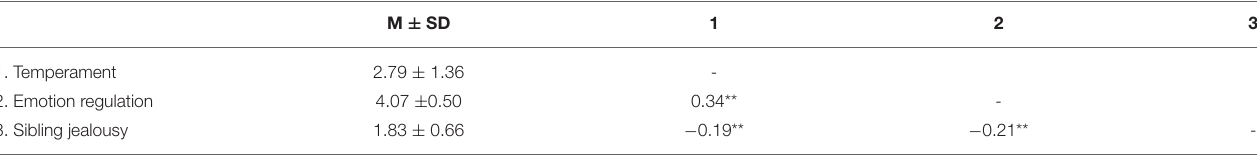
TABLE 1 | Pearson correlation coefficients of the study variables (n =